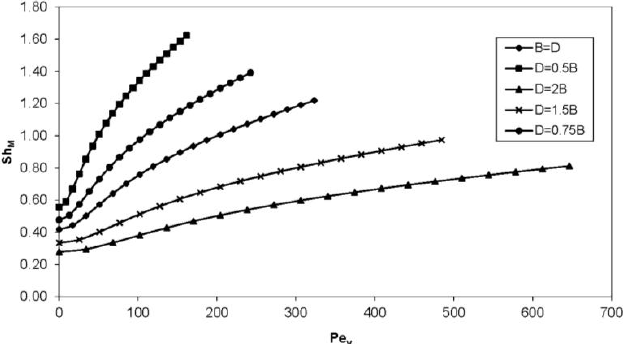
Figure 6. Dependence of the Sh M (Pe y ) function on the length of the diffusive layer. H/D = 0.1; x A1 = x A2 ; limit current; B/D ranges from 0.5 to 2.